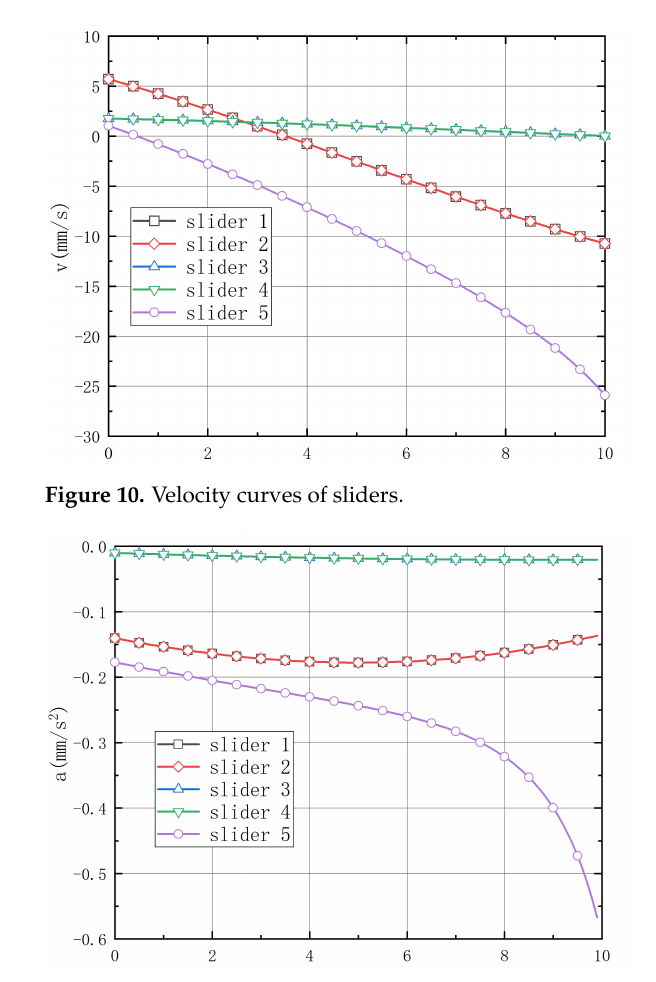
Figure 11. Acceleration curves of